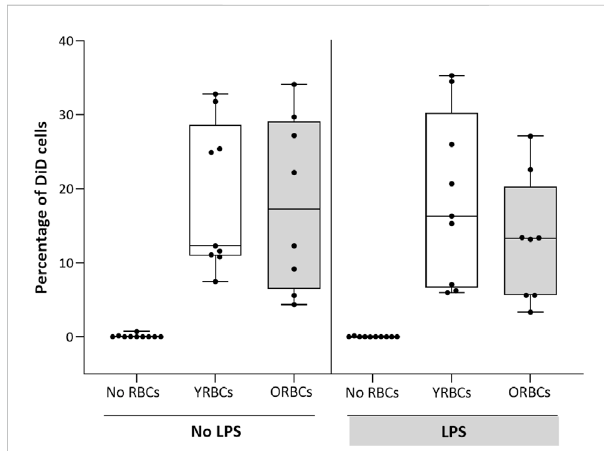
FIGURE 2 Adhesion of RBCs to endothelial cells. Young red blood cells (YRBCs) and old red blood cells (ORBCs) were stained with Vybrant ™ DiD Cell-Labeling Solution and incubated with HMVEC-L for 5 h at 37 ° C with 5% CO 2 in presence and absence of LPS. n = 8 – 10 each.